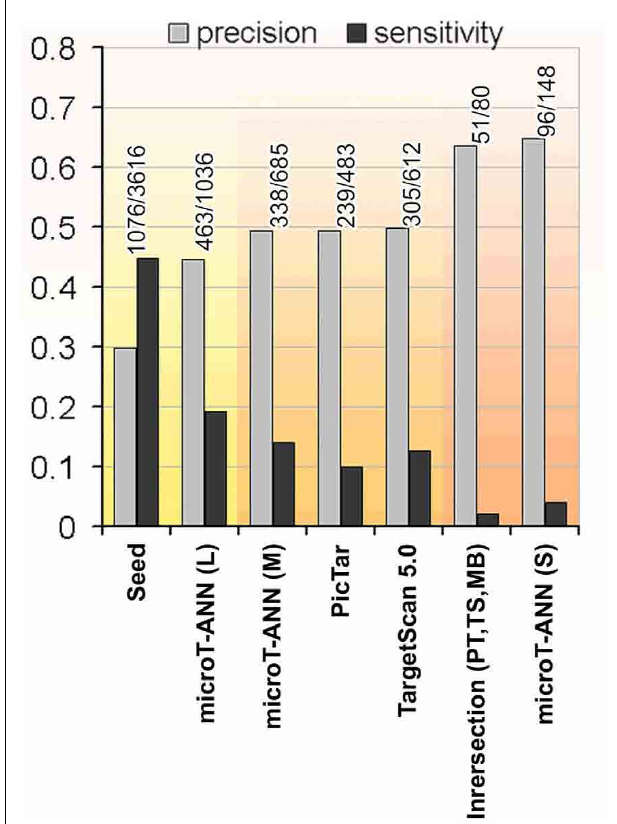
FIGURE 3 |The precision and sensitivity of representative target prediction methods tested on the proteomics data. The tested programs are: Pictar,TargetScan 5.0, and DIANA-microT-ANN using the suggested three different score cutoffs denoted as strict (S), medium (M), and loose (L). Additionally the performance of a seed occurrence measure, detecting genes containing at least one occurrence of the miRNA seed is shown as a very sensitive prediction criterion, and the commonly used intersection of the predicted targets of Pictar,TargetScan 5.0, and miRBase as a very strict and precise measure.Three groups are highlighted indicating the methods with high sensitivity, medium, and high precision (from left to